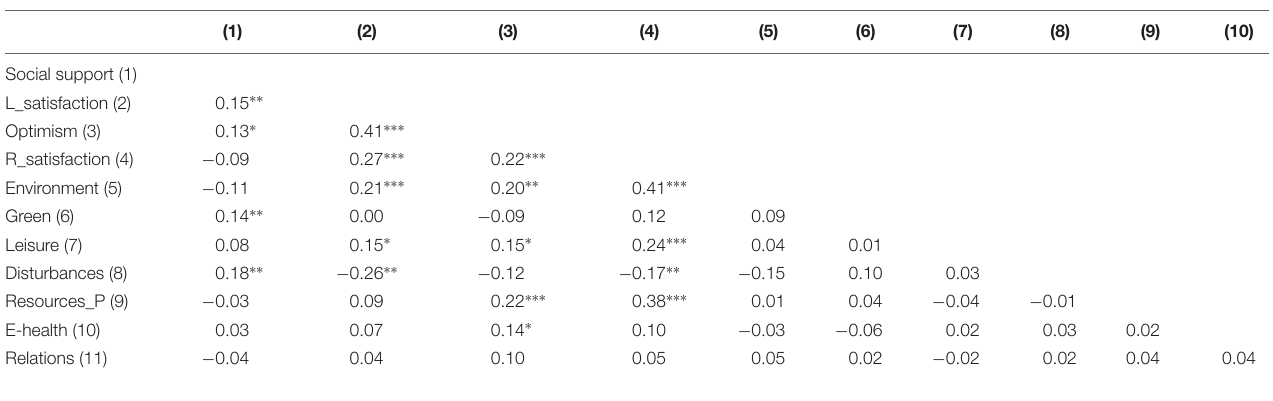
TABLE 3 | Correlations between well-being variables, factors of neighborhood perception, and residential